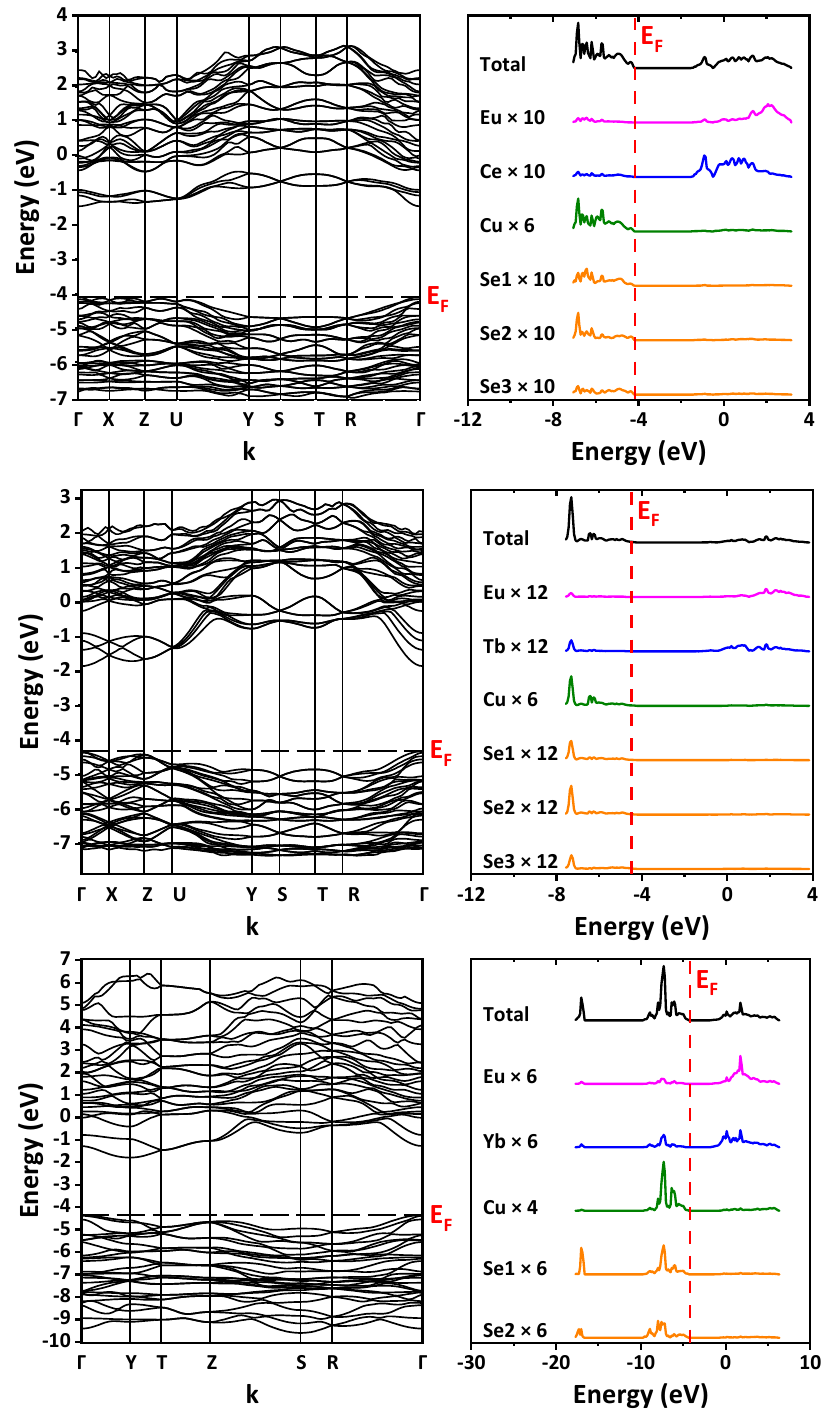
Figure 9. Band structures and the density of states for EuCeCuSe 3 ( top row ), EuTbCuSe 3 ( middle row ) and EuYbCuSe 3 ( bottom row ).